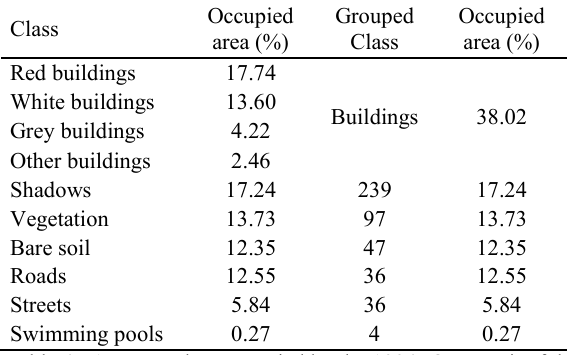
Table 4. Area per class occupied by the 1894 IOs meaningful objects manual classified.